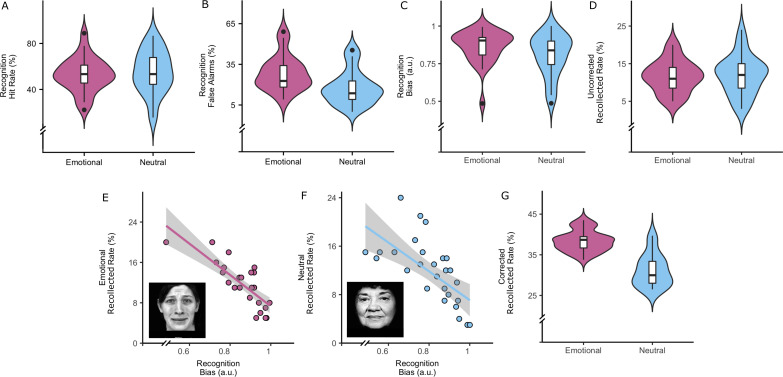
Behavioral performance (N = 27).(A) Hit rate for emotional and neutral conditions during recognition (paired Wilcoxon test: Z = −1.17, p=0.244). (B) False alarm rate for emotional and neutral conditions during recognition (paired Wilcoxon test = 3.81, p<0.001). (C) Recognition bias for emotional and neutral conditions (paired t-test, p=0.019). (D) Uncorrected recollection rate for emotional and neutral conditions (p=0.95). (E) Emotional condition: scatter-plot between recollection rate and bias c (robust linear regression: β = −30.99,t = −9.77, p<0.001). (F) Neutral condition: scatter-plot between recollection rate and bias c (robust linear regression: β = −23.78, t = −6.35, p<0.001). (G) Corrected recollection rate for emotional and neutral conditions (paired Wilcoxon test: p<0.001). Boxplots inside the violinplots show median, quartiles (boxes) and range (whiskers). Shaded regions depicts the 95% confidence interval.Figure 2—source data 1.Behavioral performance on the face-name association task.Individual hit rates, false alarms, bias scores for the recognition, recollection scores (raw and bias-adjusted) are provided for the neutral and emotional valence condition.